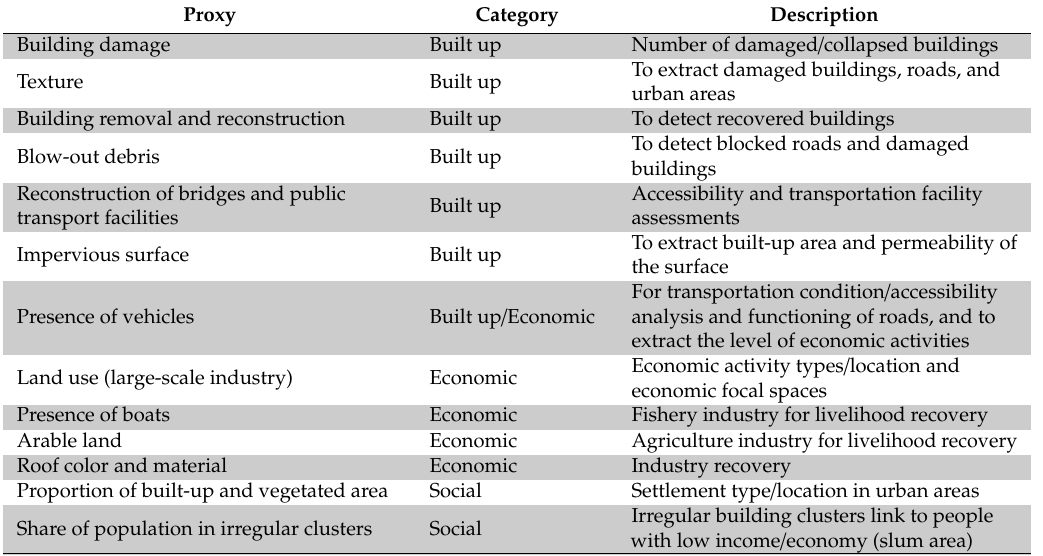
Table 2. The proxies used for the recovery